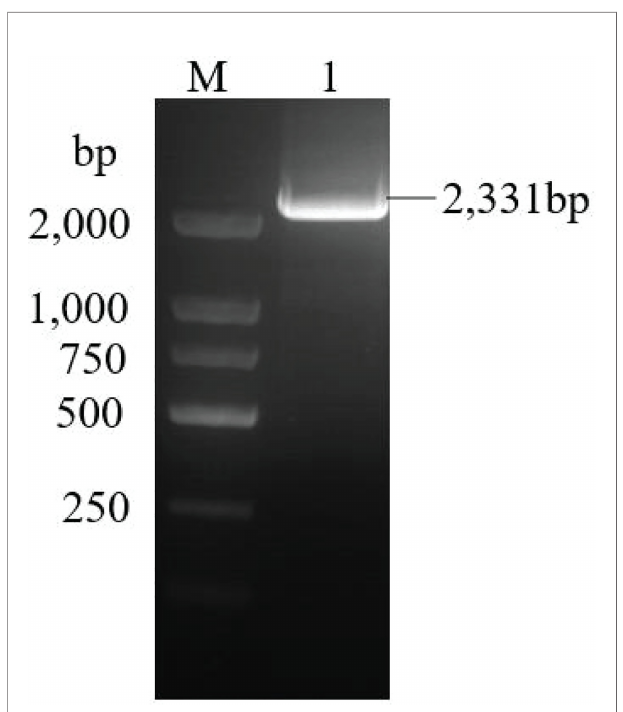
FIGURE 3 | ORF ampli fi cation of the DpAP2 gene. M: DL 2000 Marker, 1: ORF of the DpAP2 gene. The ORF of DpAP2 gene was ampli fi ed by primers AP2(N) and AP2